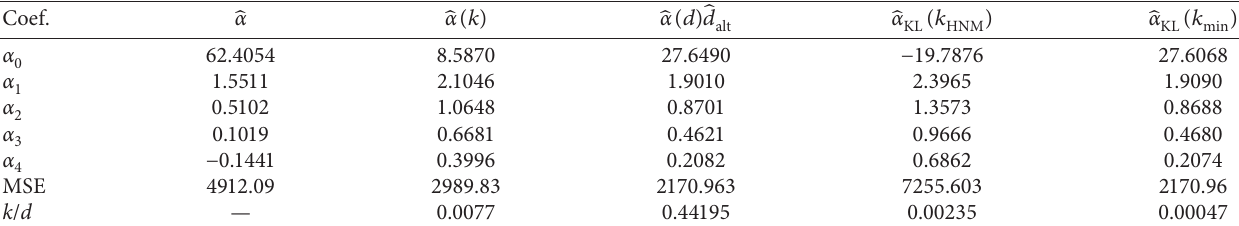
Table 10: The results of regression coefficients and the corresponding MSE values.